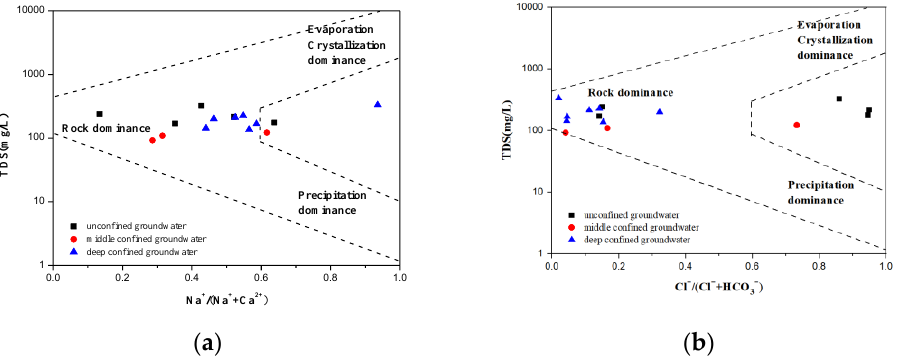
Figure 4. Gibbs diagram for ( a ) cation ratios and ( b ) anion ratios.